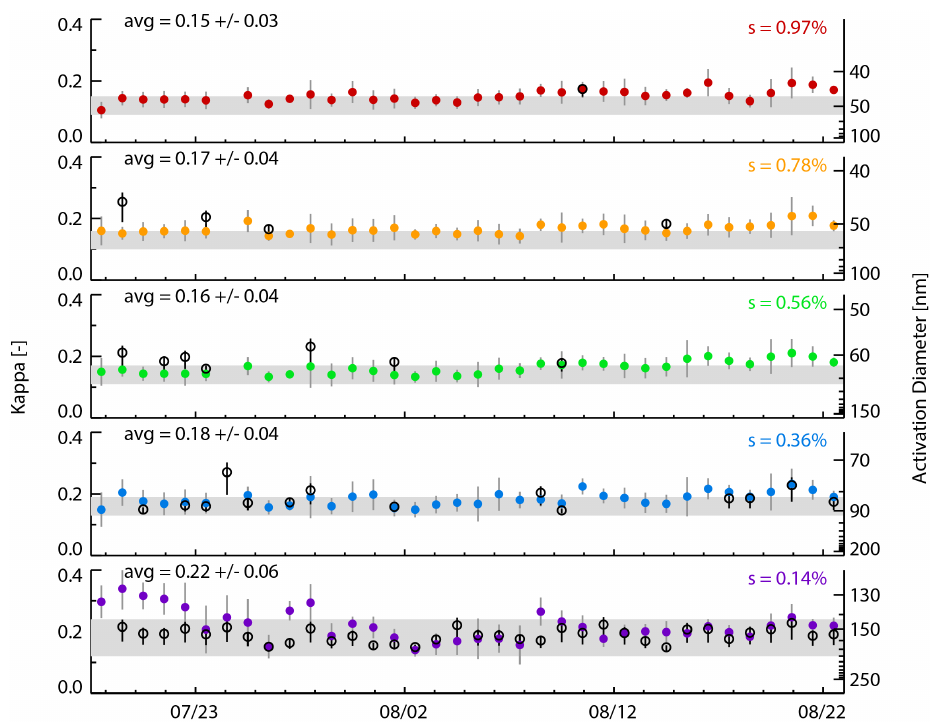
Fig. 1. Daily averaged κ values at each supersaturation setting during BEACHON-RoMBAS (colored circles) as well as calculated κ from AMS measurements (black circles). Gray bars show ± one standard deviation for measured κ values from July to August, 2011, collected during the year-long BEACHON study. Right axis indicates activation diameter corresponding to the left axis κ values at the indicated